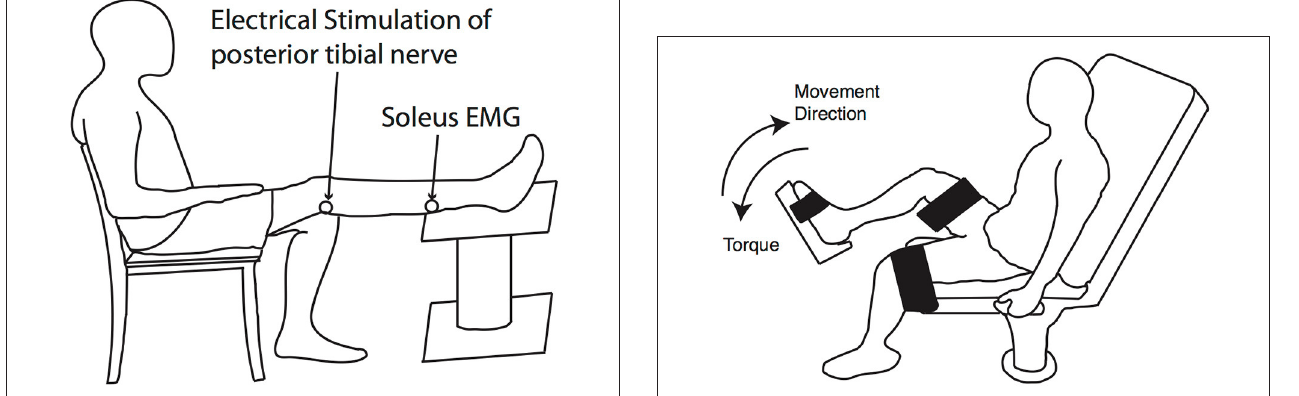
FIGURE 2 | H-reflex testing posture. The H-reflex of the soleus was obtained by applying 1ms square electrical pulses to the posterior tibial nerve through a bipolar stimulation electrode using a constant current stimulator.